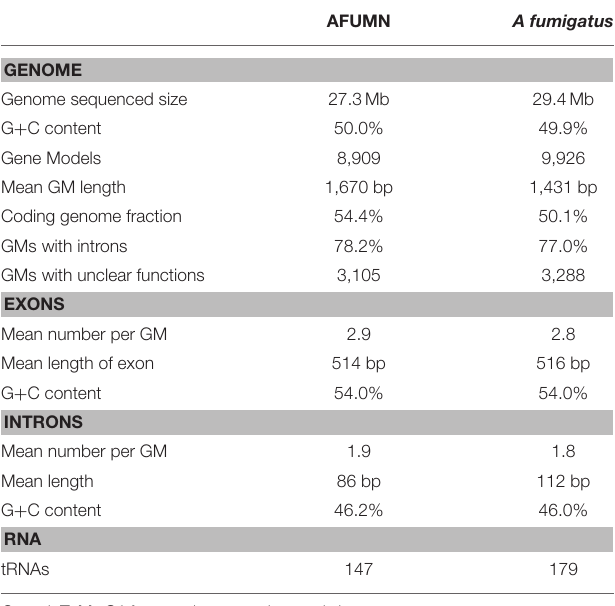
TABLE 1 | Comparison of AFUMN genome topography data.